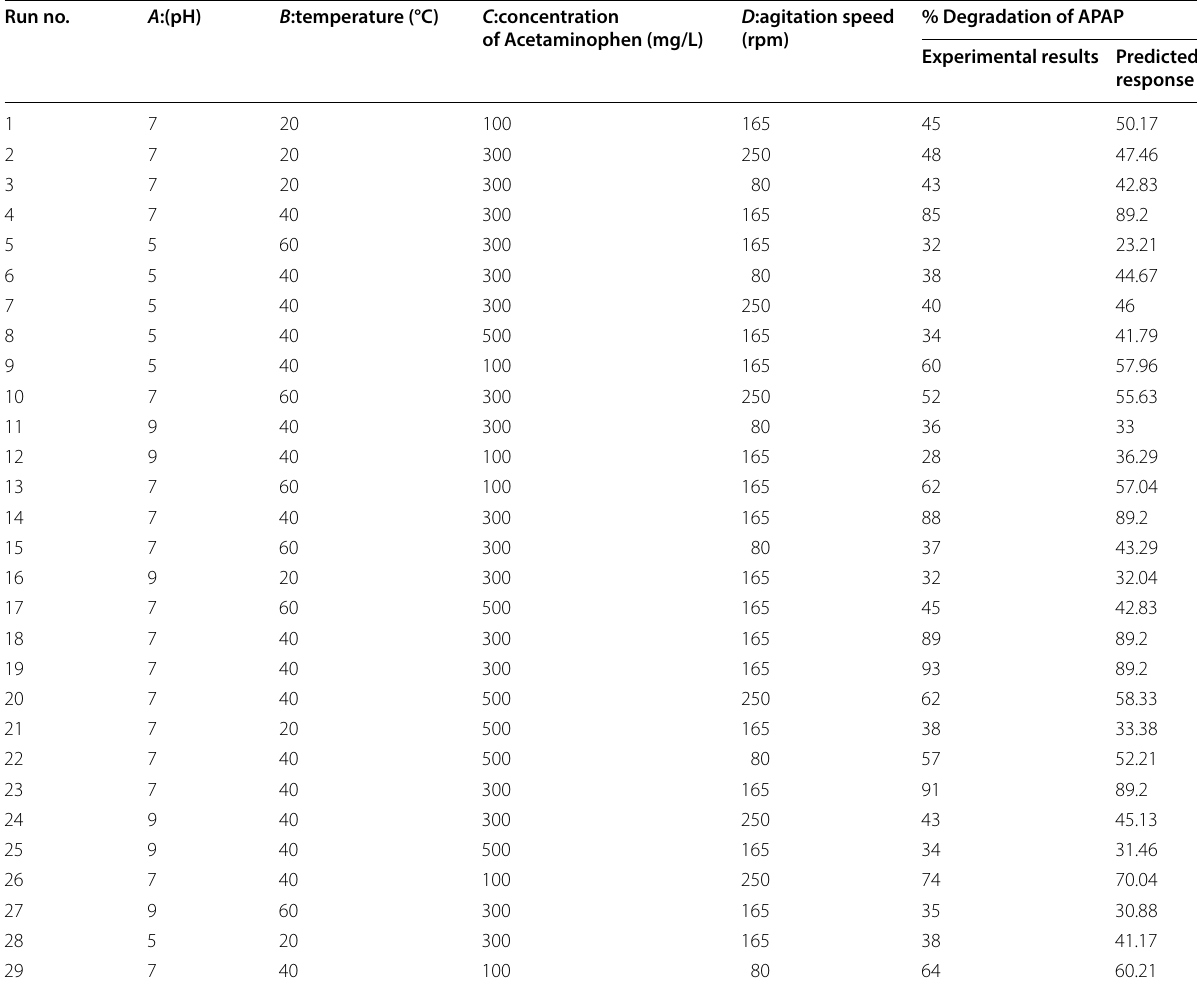
Table 1 Box–Behnken design matrix for Bacillus drentensis strain S1 degrading APAP Run